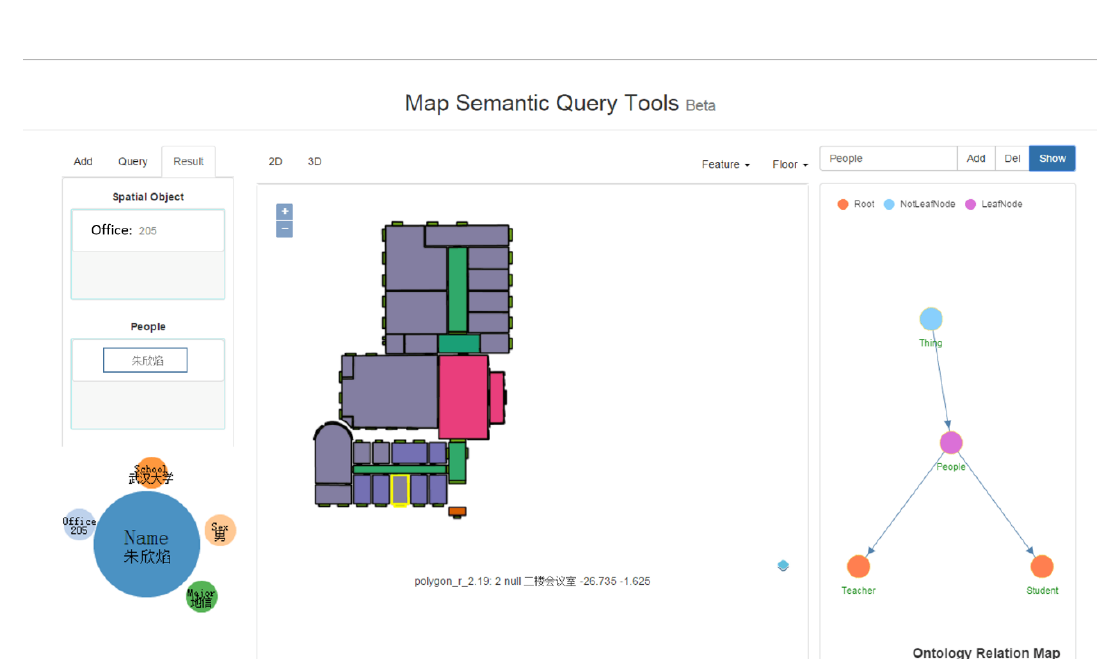
Figure 7. The Results of Example Query